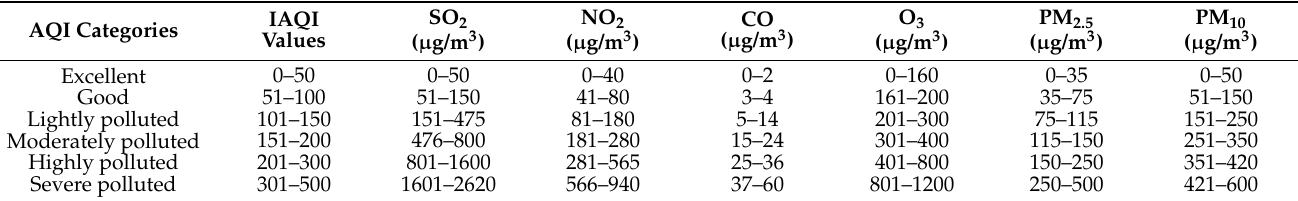
Table 1. Air quality sub-indices and corresponding pollutant concentration limitation intervals.